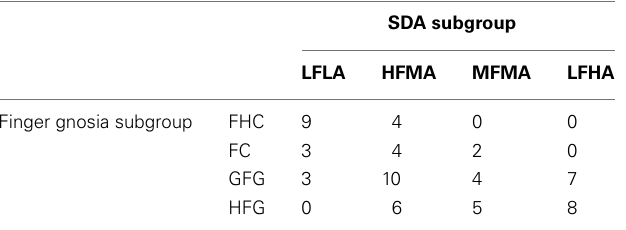
Table 6 | Cross tabulation between SDA finger-use subgroup membership and NMFG subgroup